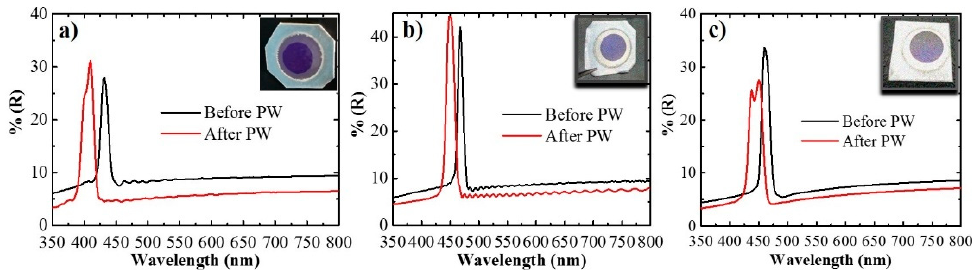
Figure 4. Reflectance spectra ( a – c ) of Hy-NAA-GIFs structure obtained for short, medium, and long samples, respectively. Inset shows the digital pictures of as-obtained samples showing the interferometric color.